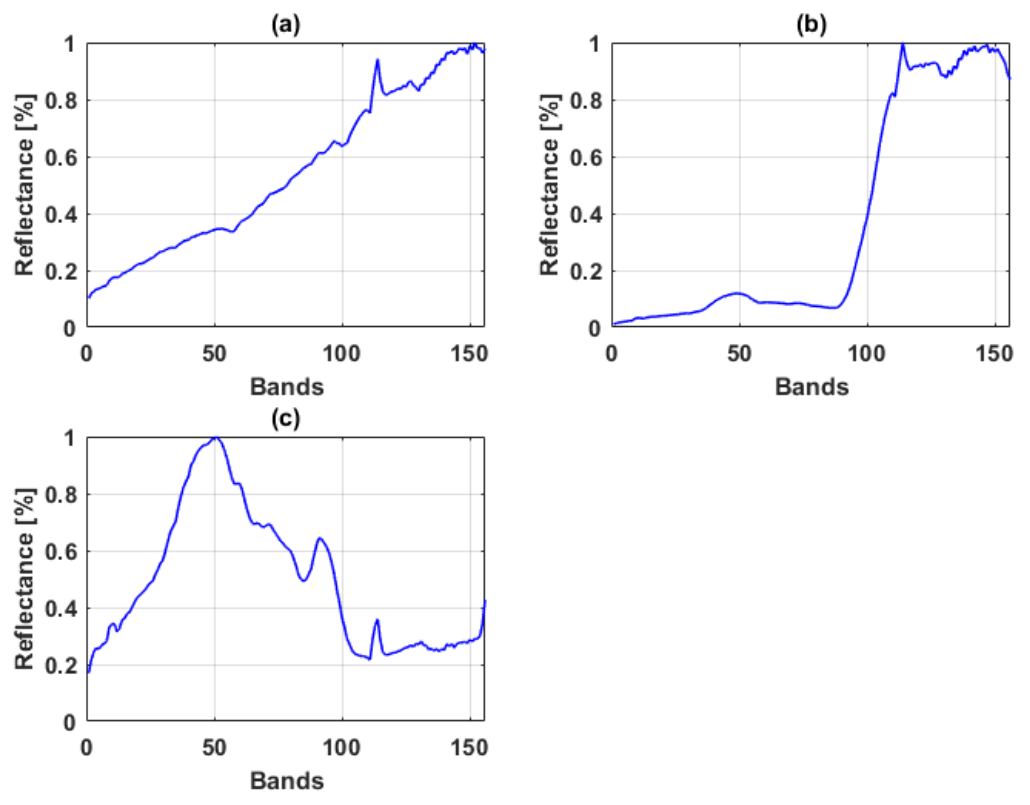
Figure 2. Spectral reflectance of endmembers of the Samson data ( a ) rock; ( b ) tree; ( c ) water. Jasper